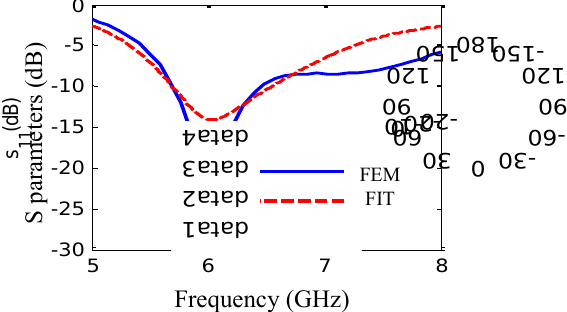
Figure 4: S-parameter simulation of SDRA antennas.